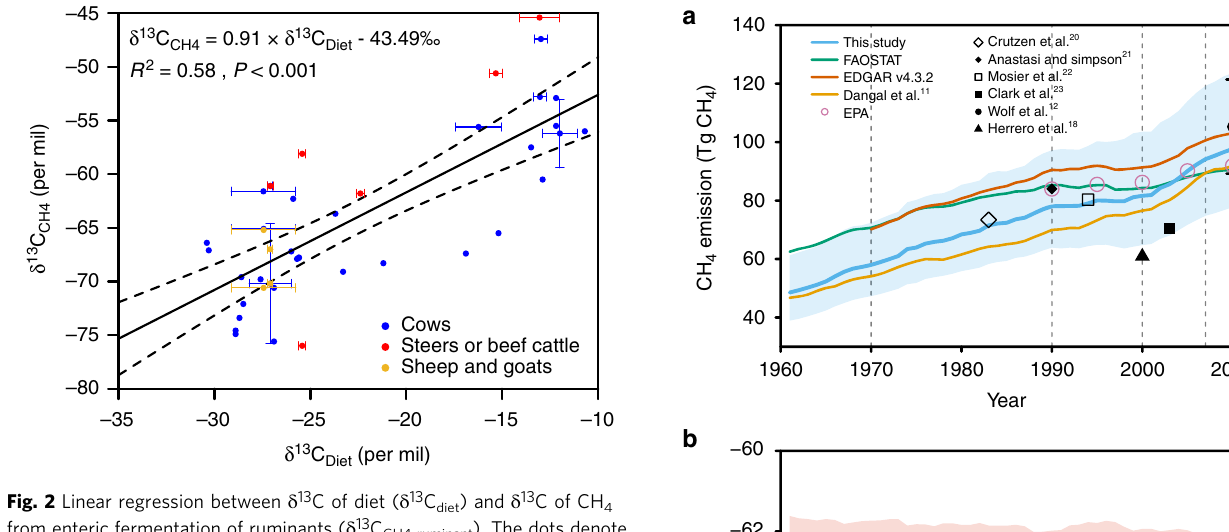
lines represent 95% con fi dence interval. The standard errors of the fi tted